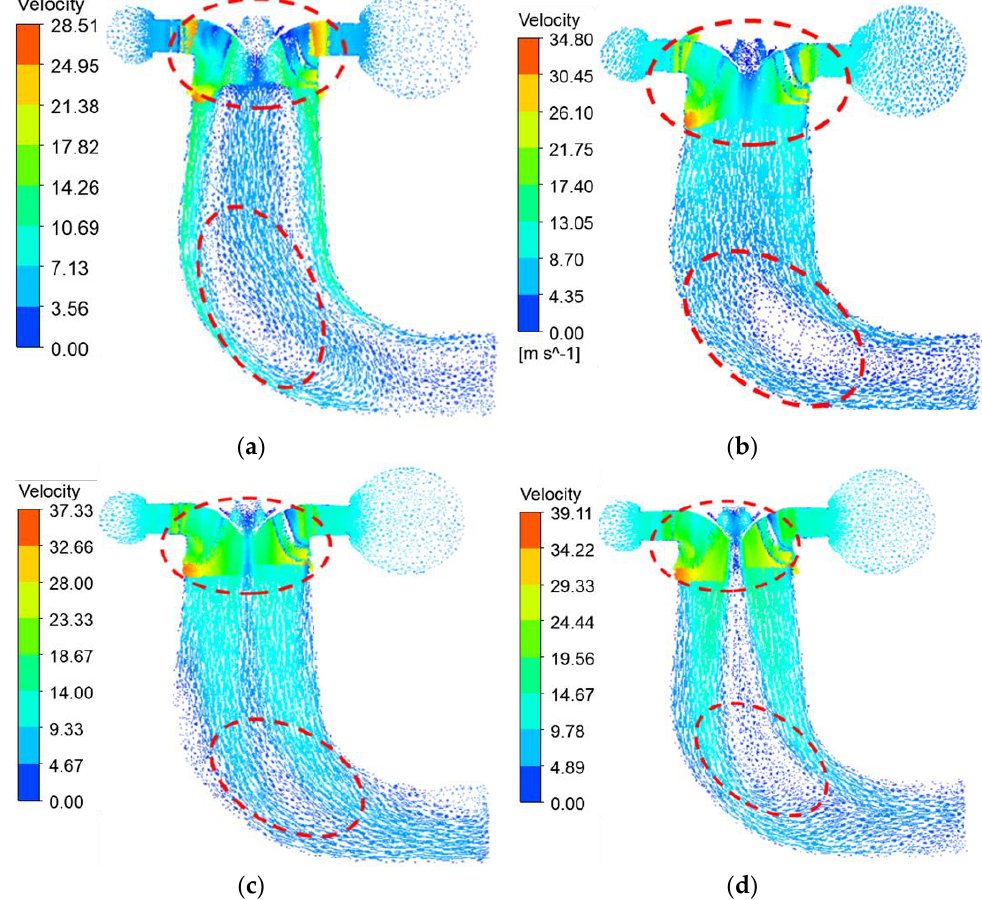
Figure 7. Overall flow velocity distribution in the channel under different guide vane opening. ( a ) 10°, ( b ) 20°, ( c ) 25°, ( d )